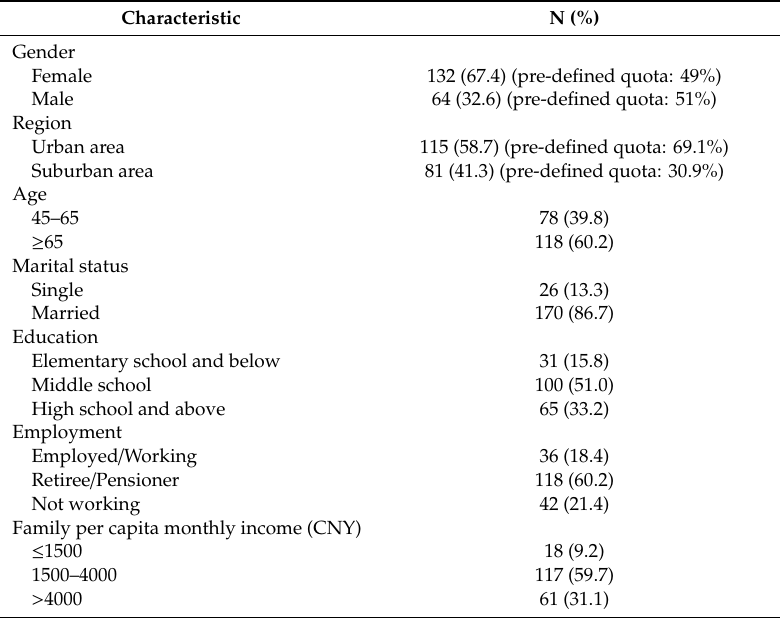
Table 2. Respondents’ characteristics (n =